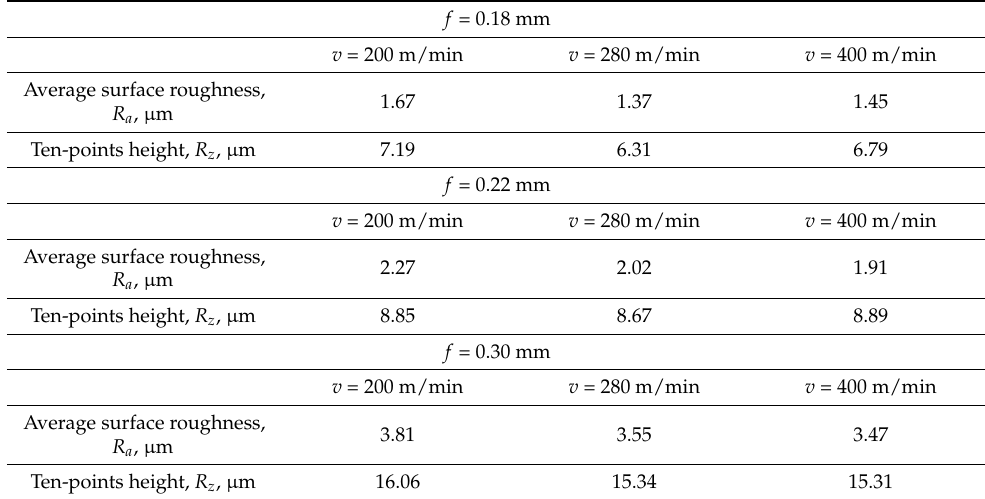
Table 3. Measured roughness values for various values of feed rate and velocity.